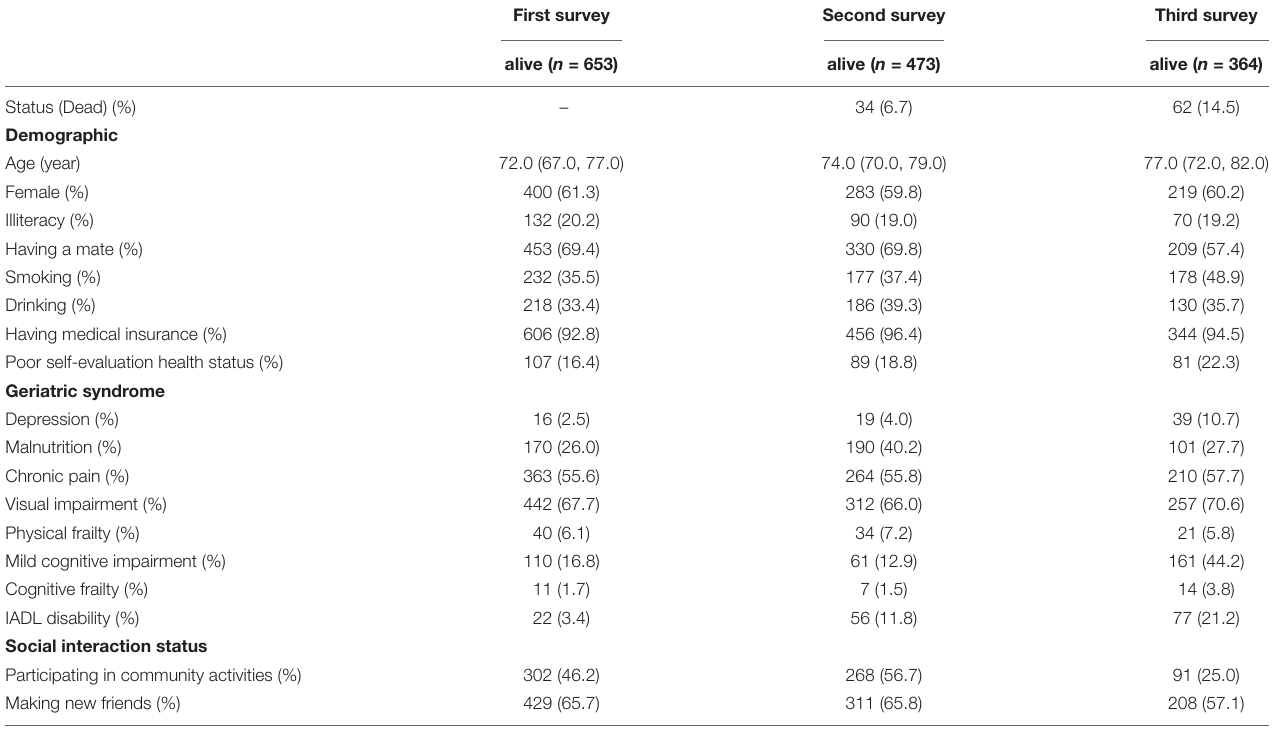
TABLE 1 | The overall characteristics of participants at each